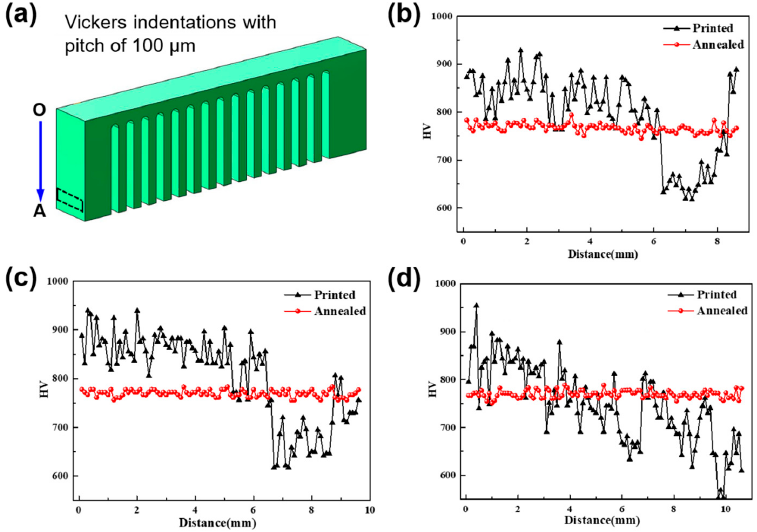
Figure 7. The Vickers hardness before and after annealing at 250 °C for 10 h along the OA direction ( a ) with pitch of 100 μ m under the XY cross scanning strategy with bar thicknesses of ( b ) 0.96 mm; ( c ) ( a ) with pitch of 100 µ m under the XY cross scanning strategy with bar thicknesses of ( b ) 0.96 mm; 1.92 mm; ( d ) 2.88 mm. ( c ) 1.92 mm; ( d ) 2.88